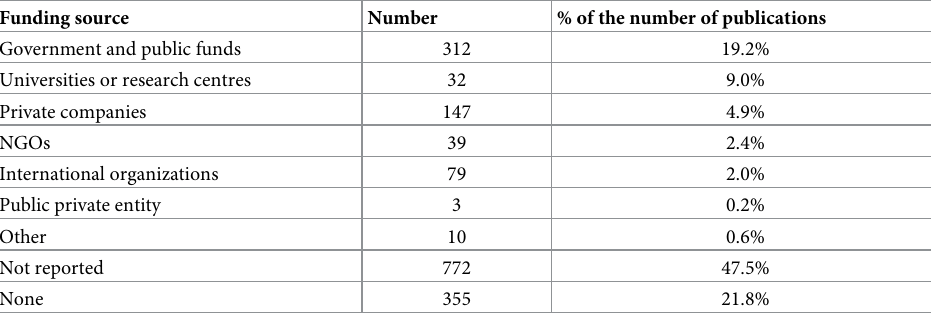
Table 3. Funding sources of empirical research related to COVID-19 in LAC